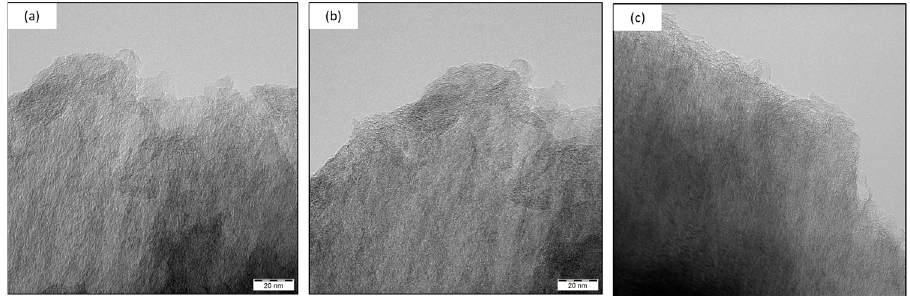
Figure 6. TEM images of the ends of the used RCF: ( a ) RCF; ( b ) MW plasma-treated for 1 min; and ( c ) RF plasma-treated for 30 s.